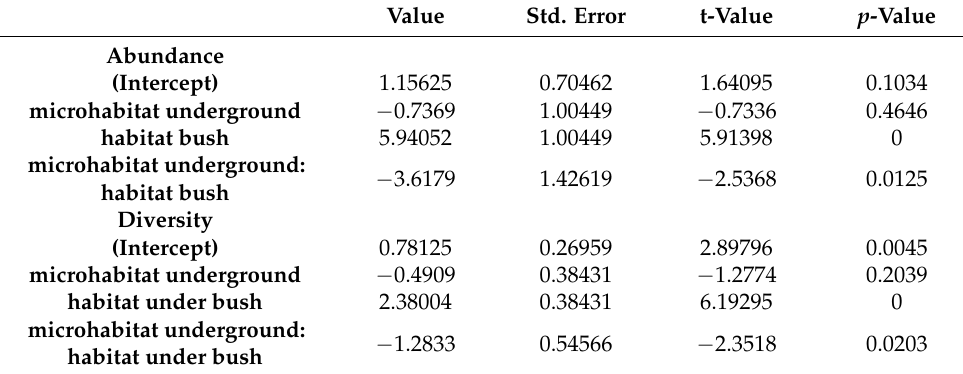
Figure 5. Distribution of the number of prey types ( upper row ) and prey items ( lower row ) in different habitats (exposed, shaded) and microhabitats (soil surface, underground) in each of 33 sampling points, collected across 4 sites of Northeastern Brazil. Lines connect samples collected at the very same microsite. Table 2. Effects of habitat (open, under vegetation) and microhabitat (soil surface, underground) over the abundance and diversity of prey in 125 samples distributed across 4 localities of the Caatinga, where BSLM lizard species have